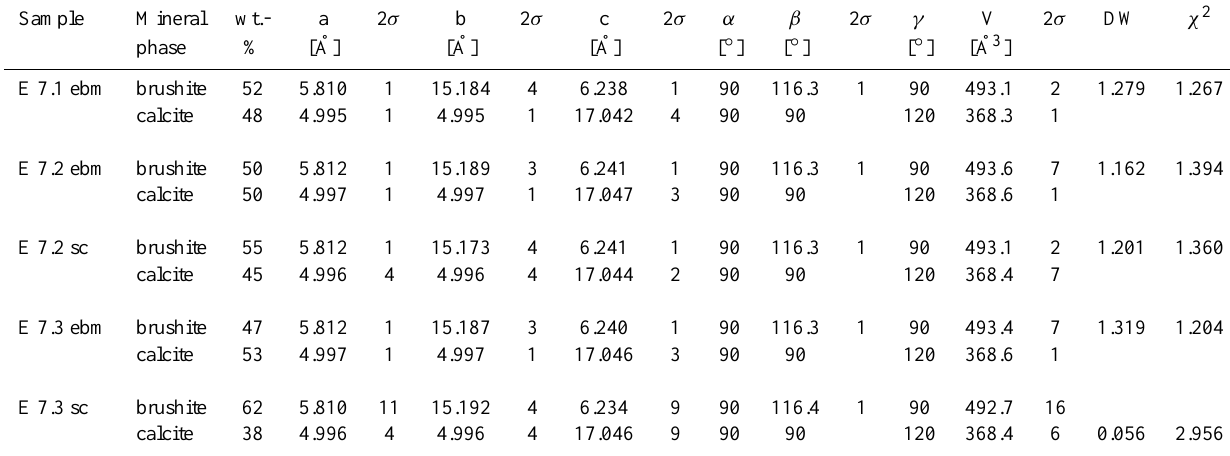
Table 2. Phase fractions, lattice constants and statistical parameters of XRD-Rietveld refinement of experimental series E7. Sample Mineral